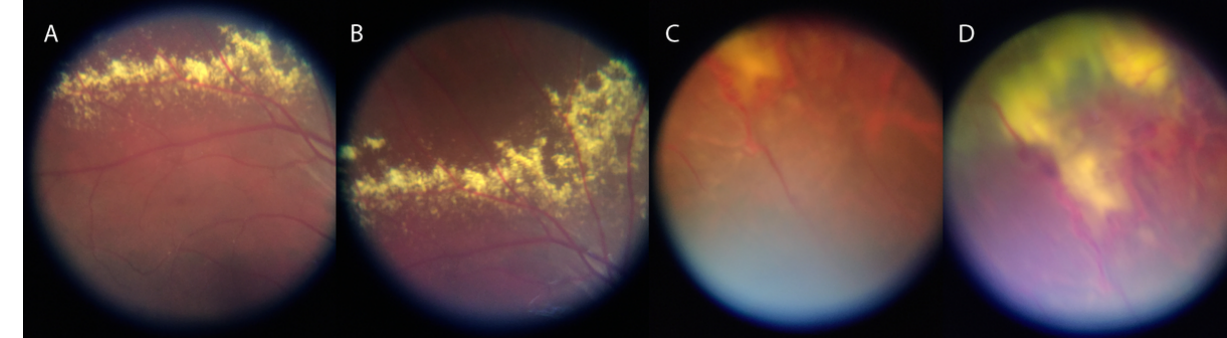
Figure 6. Smartphone-based fundus images from a 7-year-old child with Coats disease. (A) and (B) exudates superior from the upper arcade; (C) and (D) massive exudation and telangiectasia of retinal vessels in the far superior-temporal periphery, which were also funduscopically difficult to see.